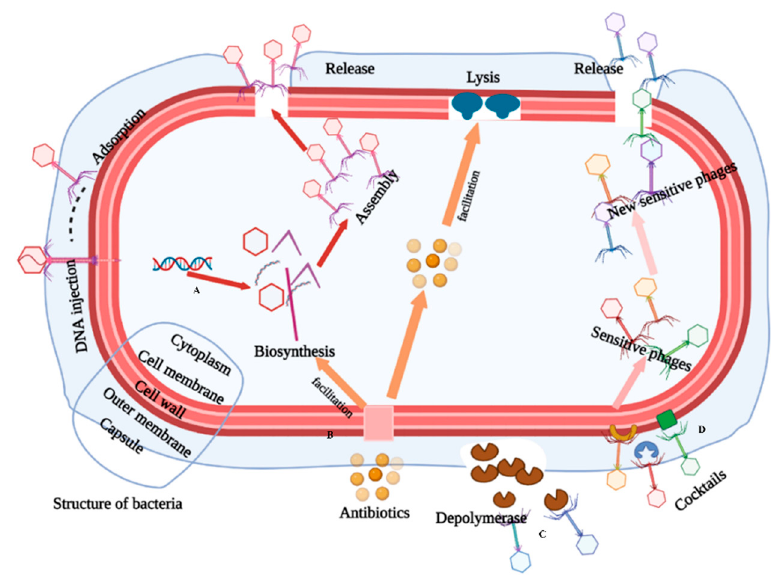
Figure 6. Phage therapy approaches. A Gram-negative bacterium that contains a cell capsule, outer membrane, and cell wall was mapped. A. Single-phage lytic bacteria; B. Combination of antibiotics and phages for use against bacteria (antibiotics facilitate the synthesis of phages). C. Phage enzyme against bacteria (depolymerase acts on extracellular polysaccharide, lysozyme acts on the cell wall). D. Cocktail therapy (multi-phage cooperative antibacterial).